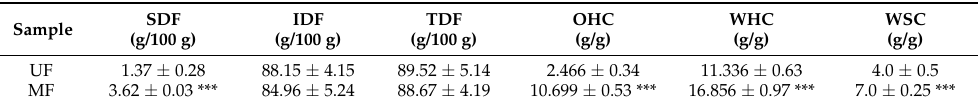
Table 4. Functional characteristics of UF and MF.